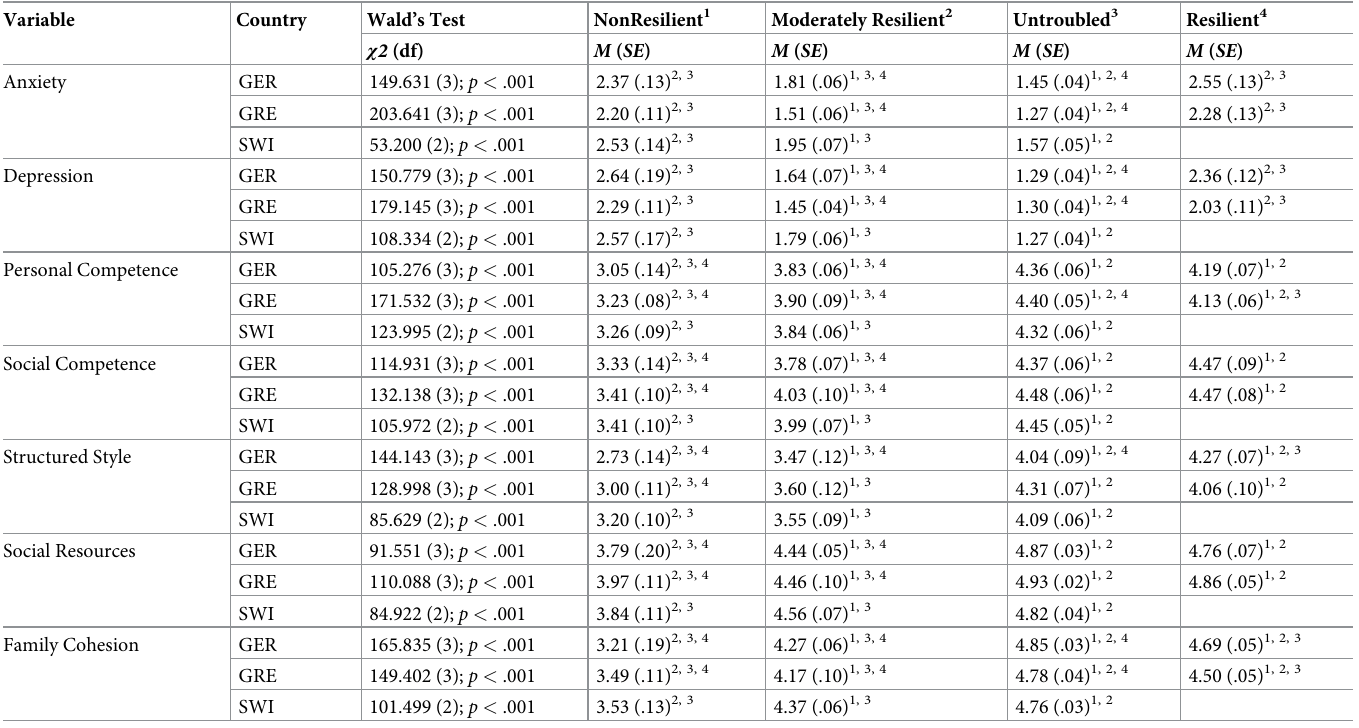
Table 3. Wald test, means, and standard errors of the